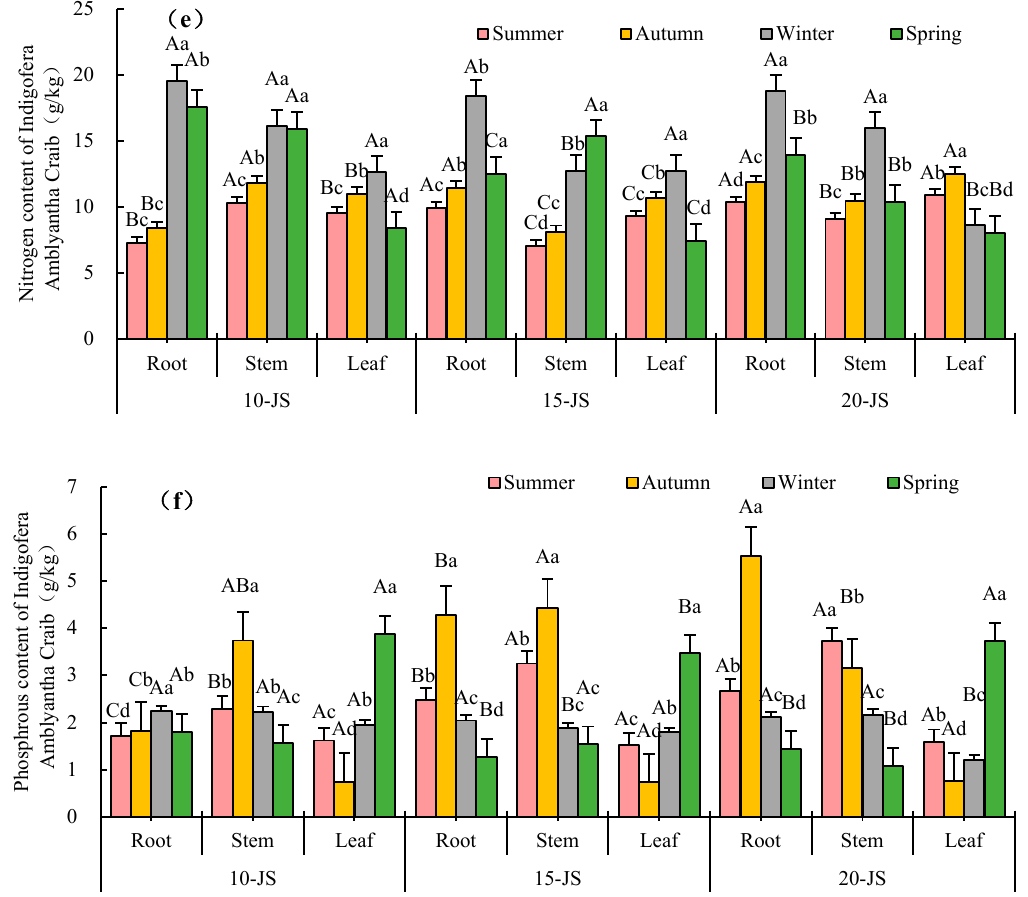
Figure 3. The plant C, N and P contents under different precipitation patterns. Note: ( a ) C content of the Cynodon, ( b ) N content of the Cynodon, ( c ) P content of the Cynodon, ( d ) C content of the Indigofera Amblyantha Craib, ( e ) N content of the Indigofera Amblyantha Craib, ( f ) P content of the Indigofera Amblyantha Craib; capital letters on different columns indicate that the same plant organ in the same season were significantly different under different precipitation ( p < 0.05); lowercase letters on different columns indicate that the same plant organ had significant differences in different seasons under the same precipitation ( p < 0.05).